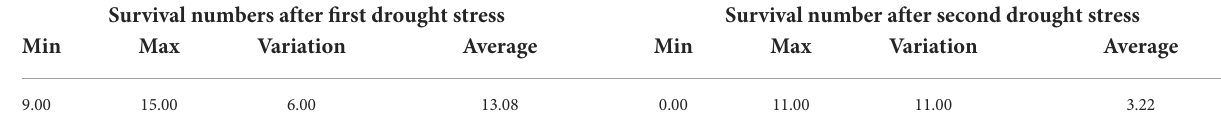
TABLE 2 Survival numbers under drought stress.